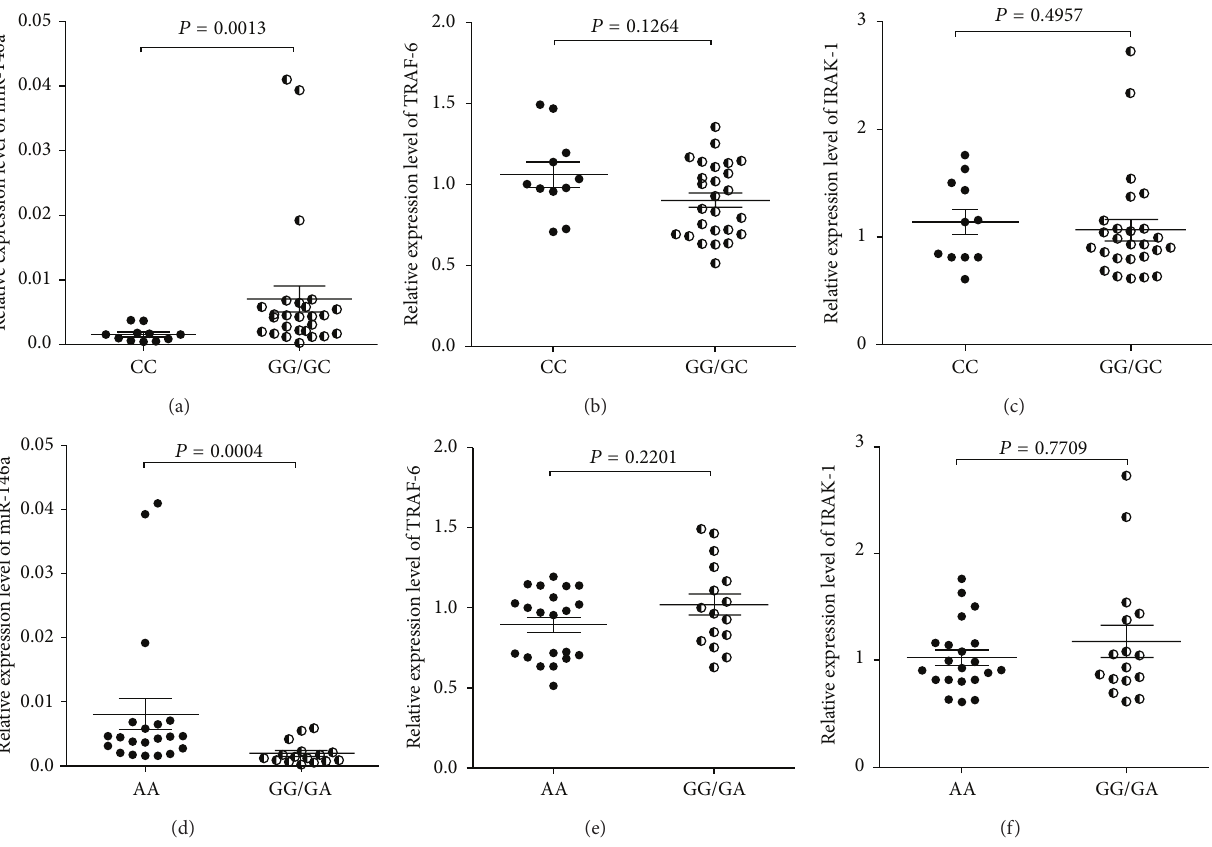
Figure 2: The distribution of miR-146a (a), TRAF-6 (b), and IRAK-1 (c) expression levels in groups of severe sepsis patients with different rs2910164 genotypes. The distribution of miR-146a (d), TRAF-6 (e), and IRAK-1 (f) expression levels between groups of severe sepsis with different rs57095329 genotypes. The horizontal line stands for the median expression level with each